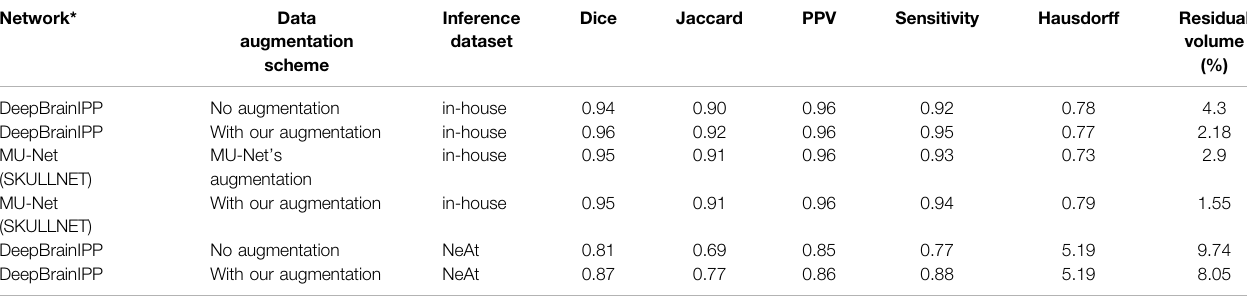
TABLE 3 | Performance of skull stripping: DeepBrainIPP versus MU-Net.